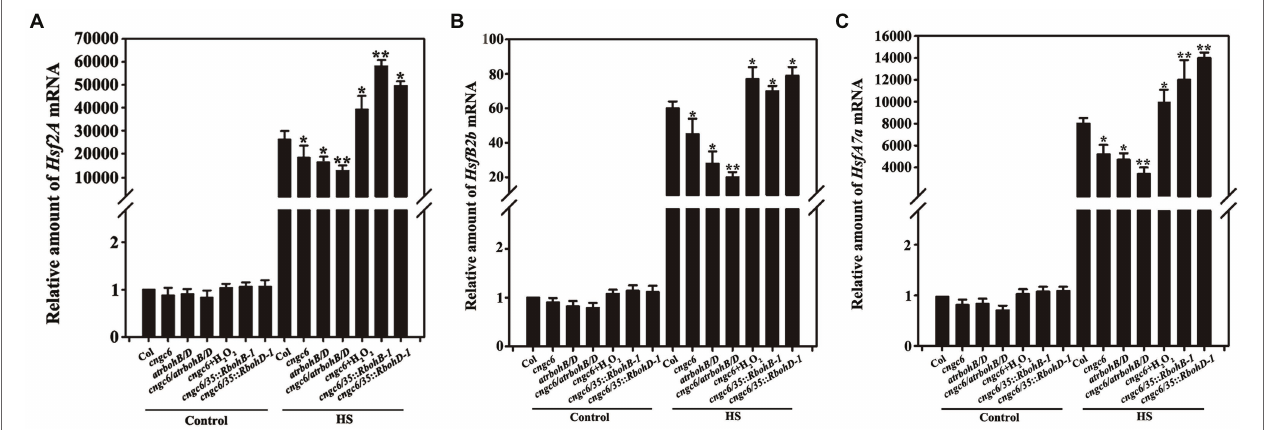
FIGURE 7 | Analysis of the effects of CNGC6 on H 2 O 2 -induced Hsfs by RT-qPCR. About 10-day-old seedlings grown at 22 ° C was exposed to 37 ° C (HS) or maintained at 22 ° C (Control) for 60 min, then used for analysis of Hsf ( A , Hsf2A ; B , HsfA7a ; and C , HsfB2b ) mRNA expression. The data are the mean ± SE of at least five independent experiments. * p < 0.05 and ** p < 0.01 vs. Col (Student’s t -test).